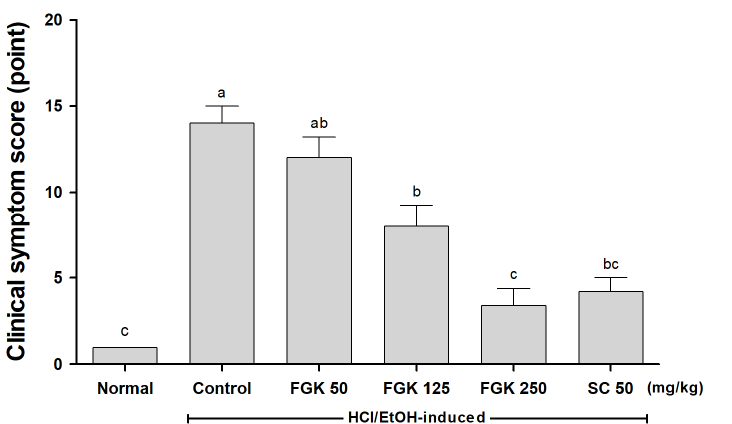
Figure 2. Effect of fermented gold kiwi (FGK) extract on clinical symptoms in HCl/EtOH-induced rats. Normal, rats treated with only DW; Control, rats treated with HCl/EtOH; SC 50, rats treated with HCl/EtOH and sucralfate 50 mg/kg; FGK, rats treated with HCl/EtOH and FGK (50, 125, and 250 mg/kg). Results are expressed as mean ± SEM (N = 8). a–c Different labels were significantly different at p < 0.05 between treatments, as determined by Tukey’s analysis.